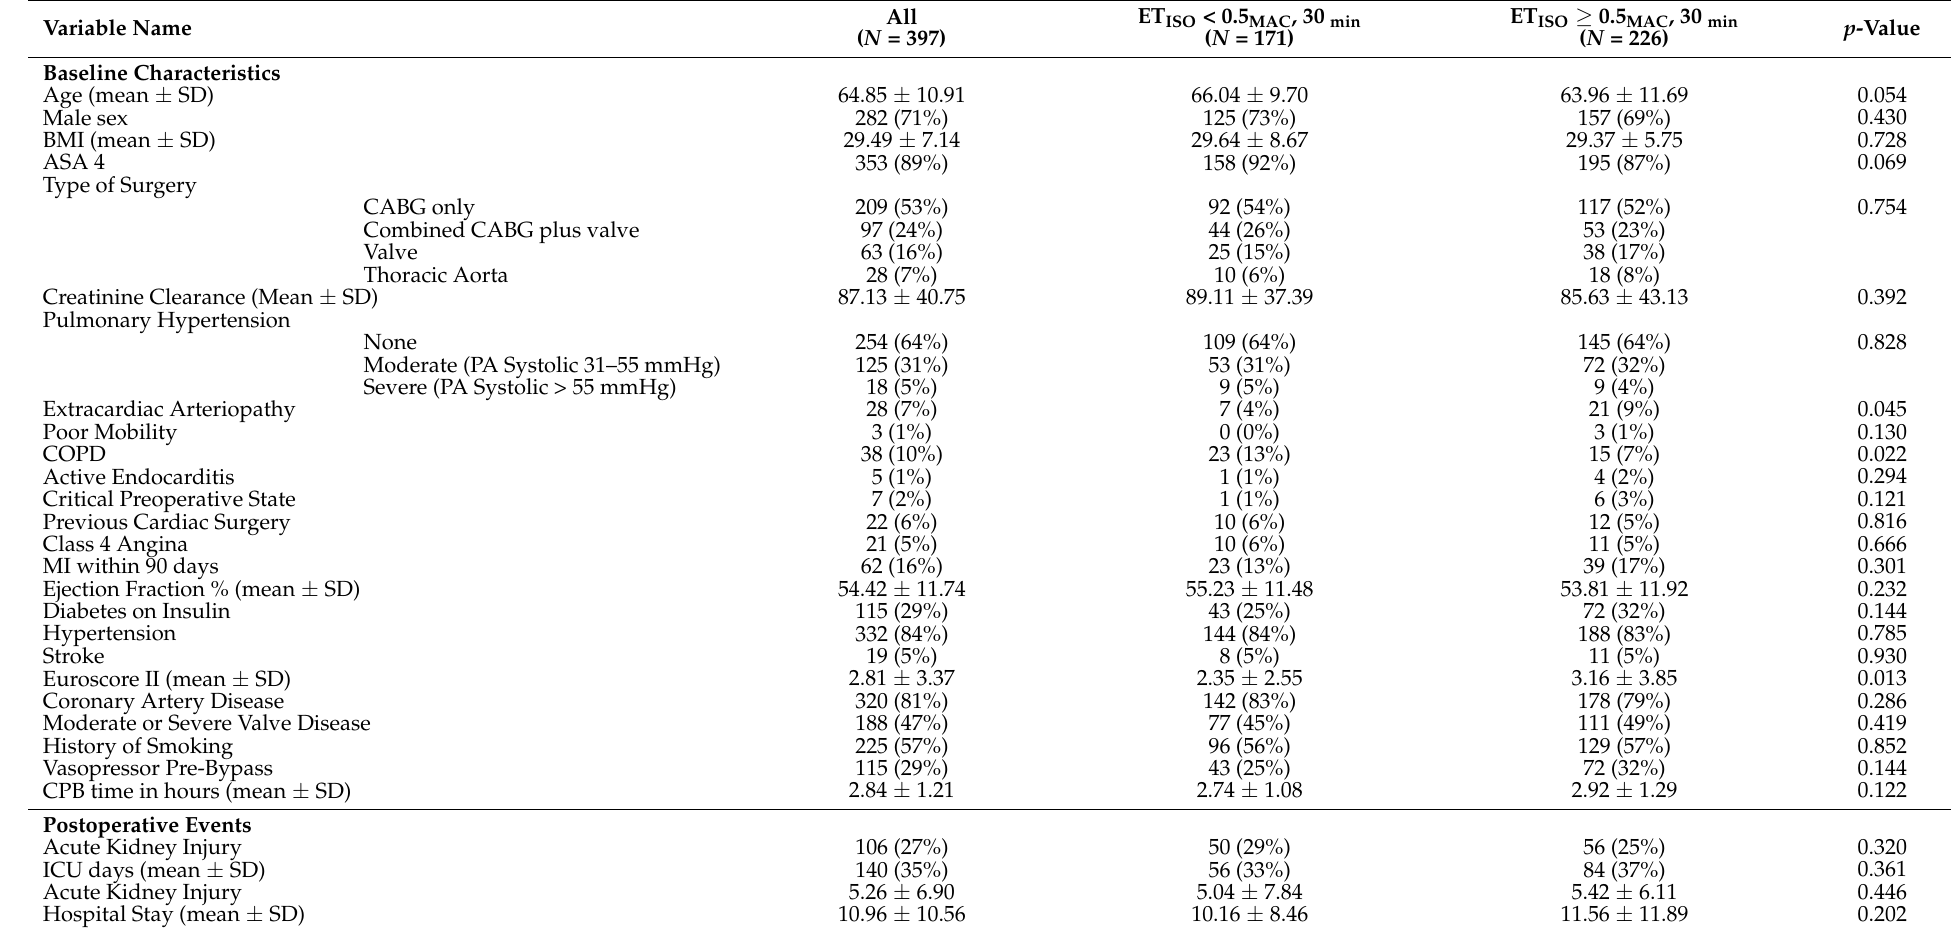
Table 1. Baseline Characteristics and Postoperative Events with Distinction of the Inhaled Anesthetic Dose during the Post-Bypass